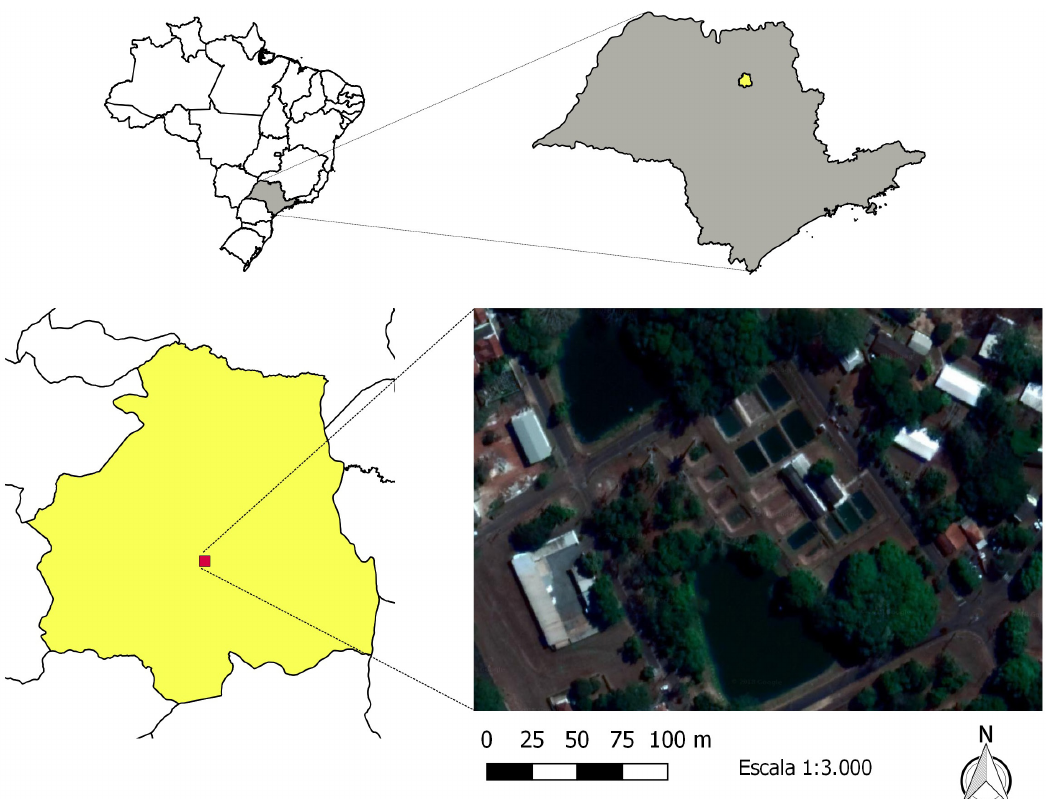
Figure 1. Location of the Crustacean Sector of the Aquaculture Center of São Paulo State University in São Paulo state (Brazil). Image from Google Earth (access in